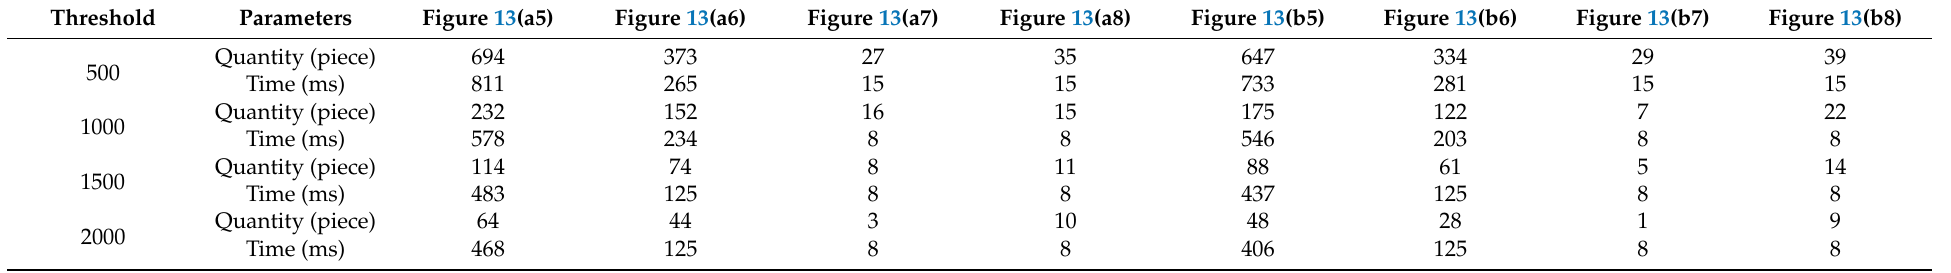
Table 3. Comparison of image feature extraction by different threshold values of Hessian matrix determinant response